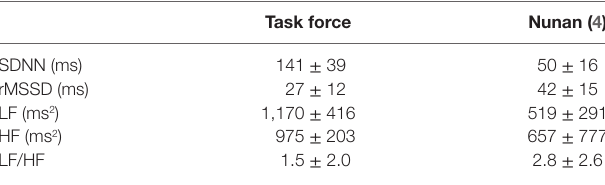
Table 4 | Reference values for some heart rate variability values provided by the Task Force and Nunan {(4) #2317} {(2)